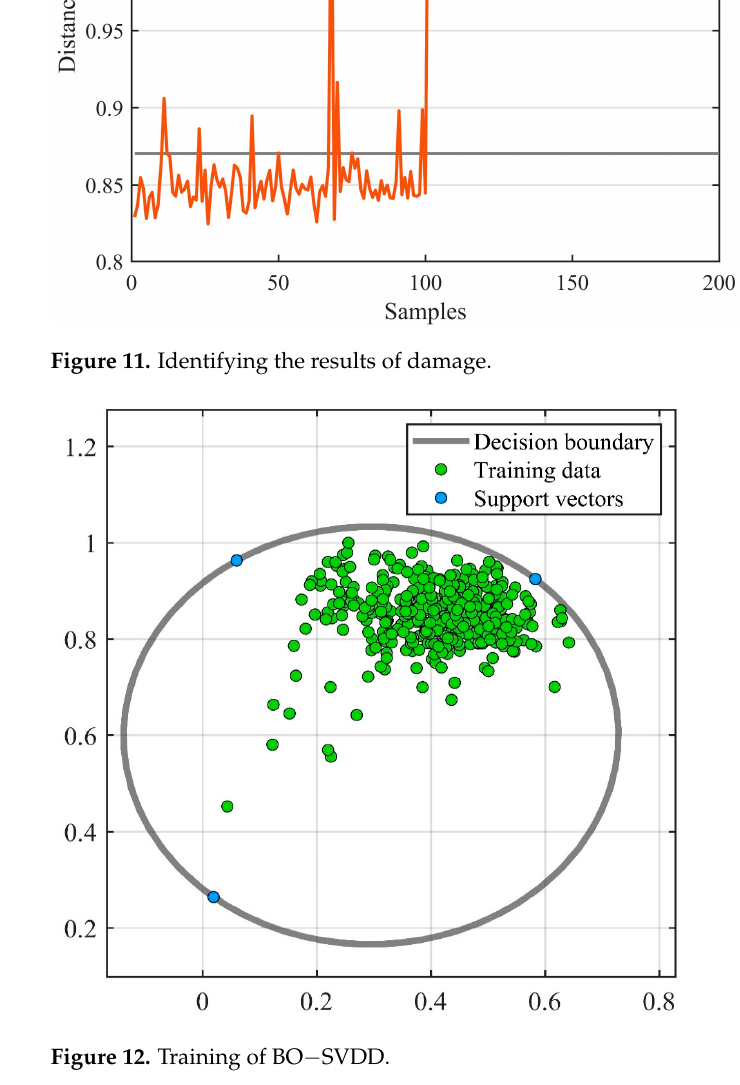
Figure 12. Training of BO − SVDD.